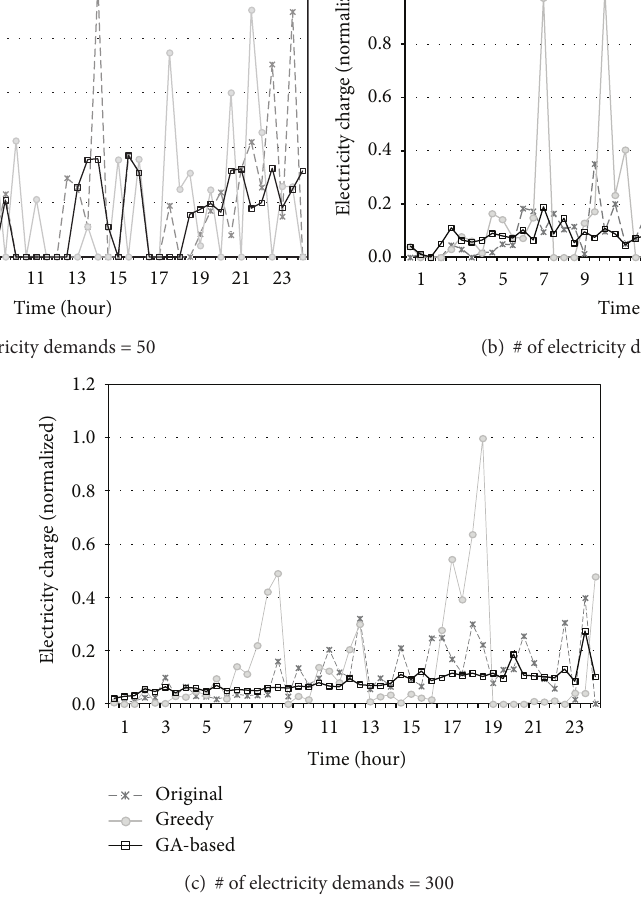
Figure 11: Electricity charges of each time slot of a